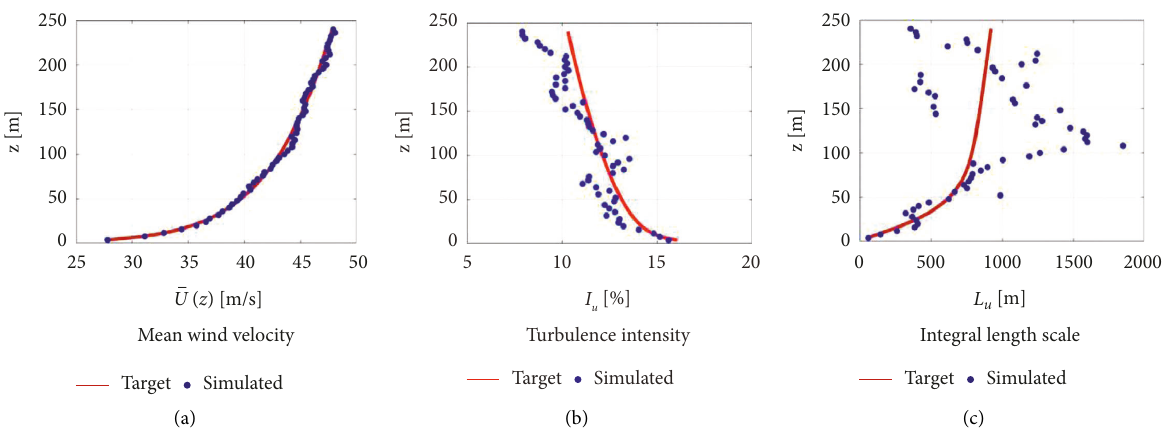
Figure 16: Longitudinal turbulence parameters along the height H/sqrt(BD) �